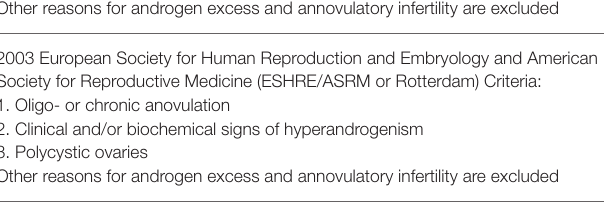
TABLE 2 | Summarizes the different diagnostic criteria for PCOS. A comparison of diagnostic criteria for polycystic ovary syndrome 1990 National Institute of Child Health and Human Development (NICHD) diagnostic